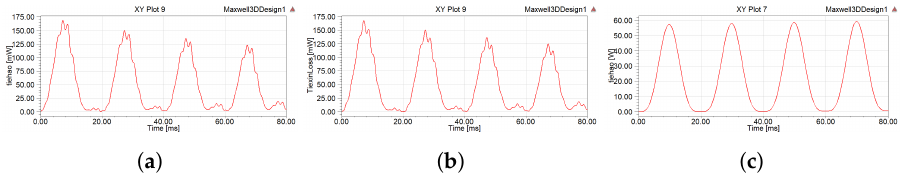
Figure 22. Curves of core loss characteristics under the three working conditions. ( a ) Working condition 1. ( b ) Working condition 2. ( c ) Working condition